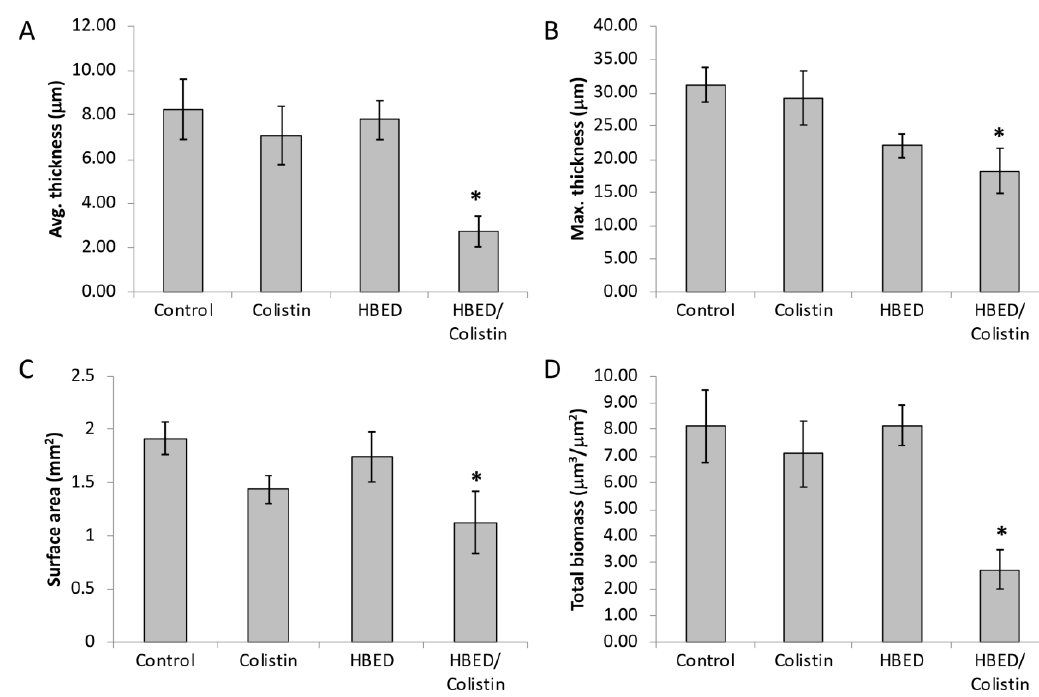
Figure 5. COMSTAT analysis of P. aeruginosa biofilms. P. aeruginosa PA605 was grown for a total of 10 days with treatment (HBED (100 µ M) and / or colistin (10 mg / L)) being incorporated into the media after six days. Biofilms were stained with LIVE / DEAD ® stain and viewed using confocal scanning laser microscopy (CSLM). ( A ) Average biofilm thickness. ( B ) Maximum biofilm thickness. ( C ) Surface area of biomass. ( D ) Total biomass. *Significantly di ff erent from the control (95% confidence) determined using ANOVA with Dunnett’s Method post hoc test. The values are the means +/ − standard error